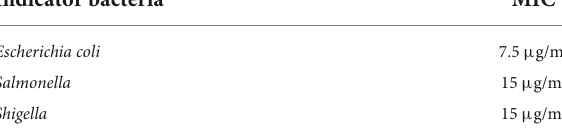
TABLE 1 Results of minimum inhibitory concentration (MIC) of BVYA1 to indicator